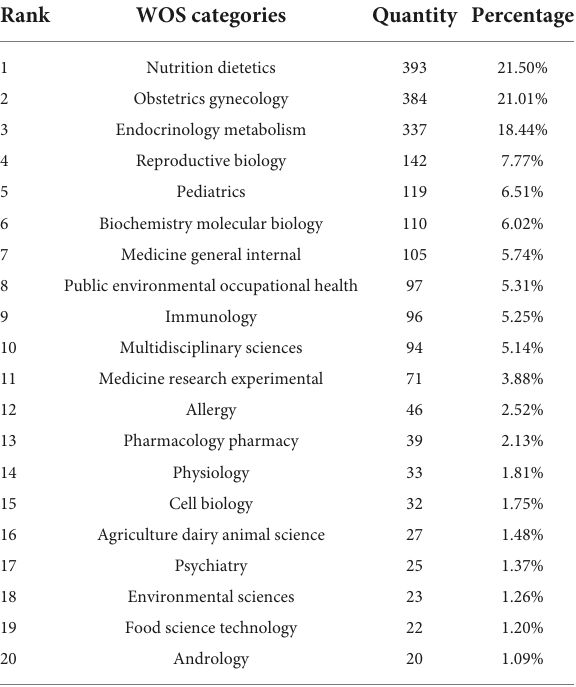
TABLE 4 The top 20 subject categories in the studies of vitamin D and reproductive health.